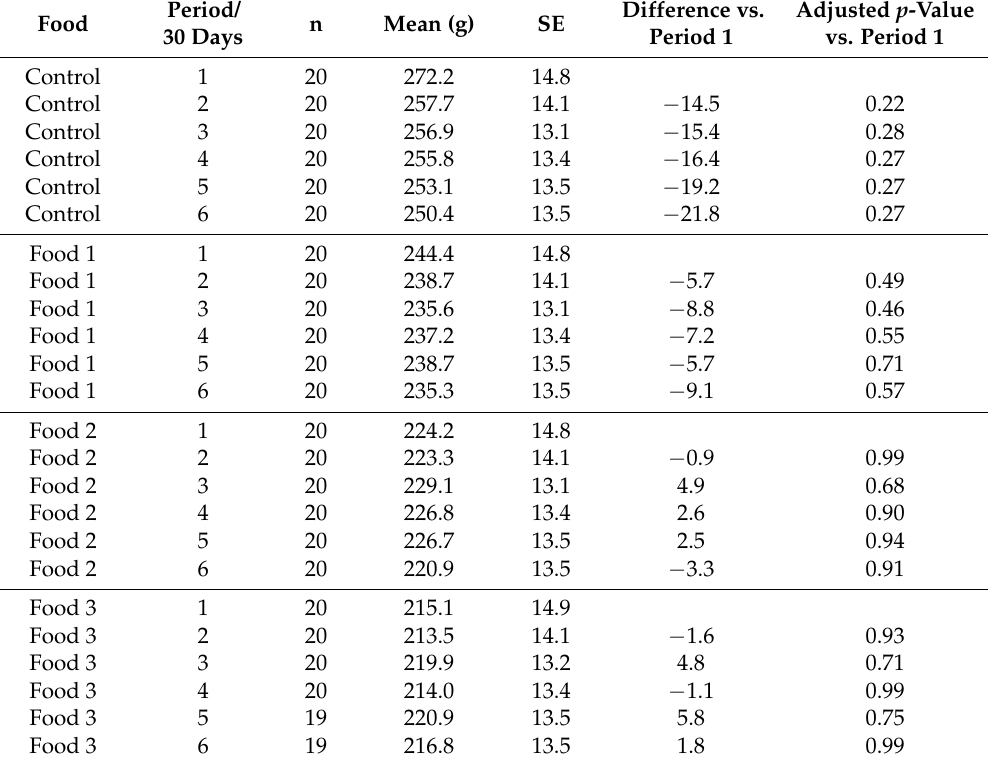
Table 4. Mean food intake by 30 day periods for all groups, difference in mean and standard error (SE) food intake between groups during every period/month of the test phase. One animal in Food 3 group was euthanized in Period 4 and hence for Food 3, n = 19 for Periods 5 and 6. (Control, Food